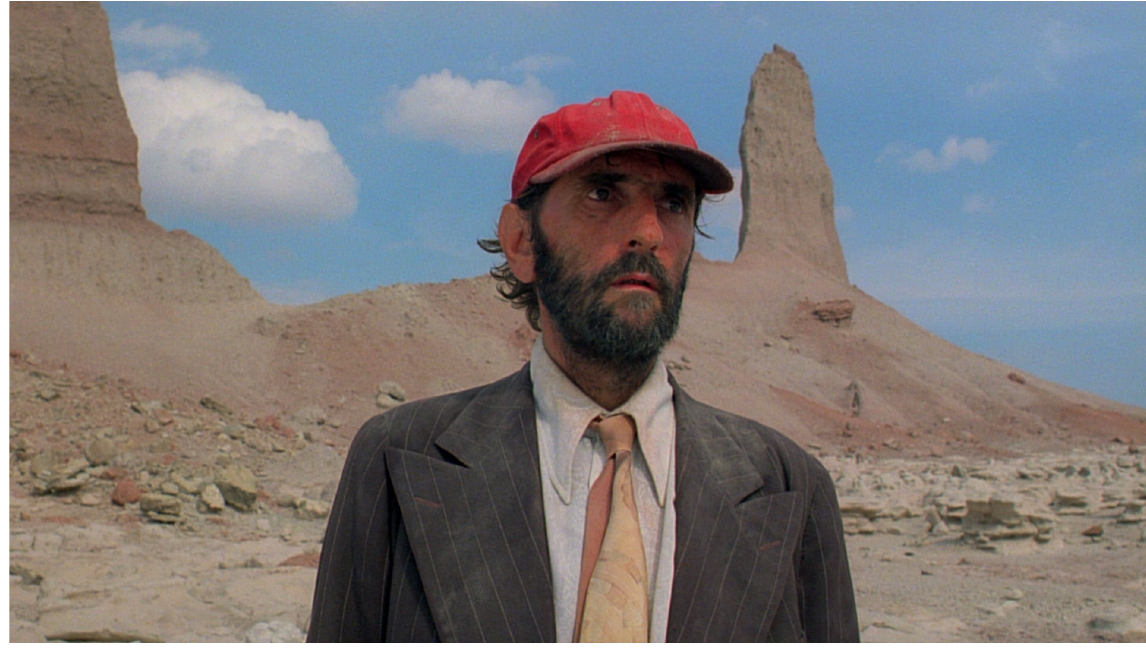
Figure 4: Travis travelling alone in Paris, Texas